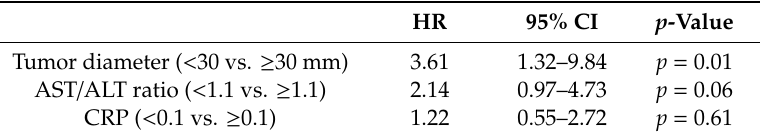
Table 3. Multivariate analysis for pathological T3a